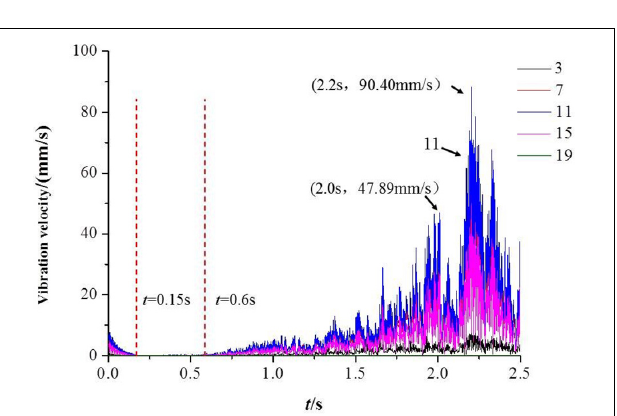
FIGURE 9 | Maximum deformation at different monitoring nodes.